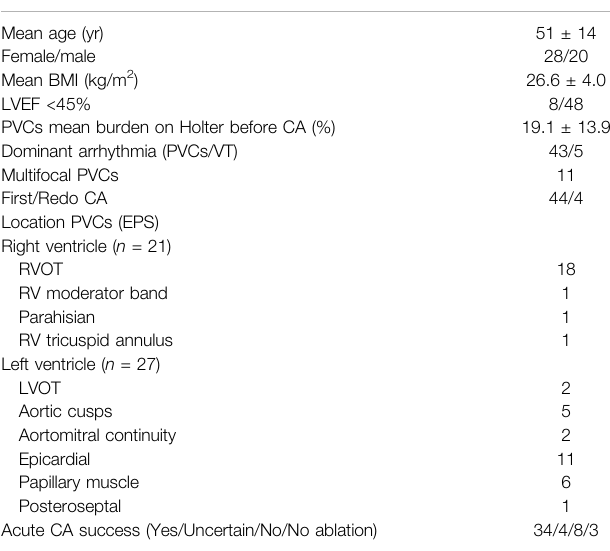
TABLE 1 | Patient and procedural